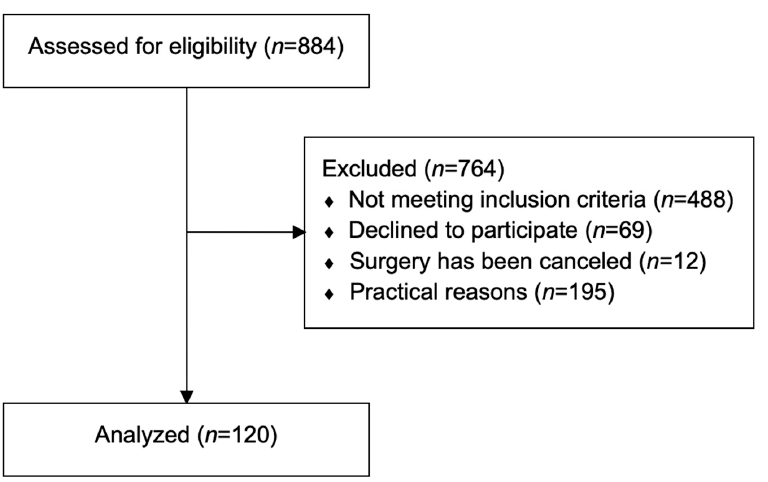
Figure 1. Flowchart. Figure 1.